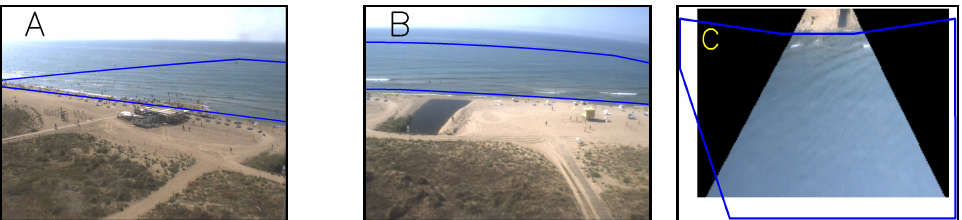
Figure 10. Images from Castelldefels beach station. Raw images from the two (out of five) cameras considered ( A , B ) and the planview ( C ) obtained from image B. The boundary of the domain to obtain the bathymetry is shown in blue. The black part in C corresponds to the part of the planview domain (rectangular) which is not reached by the